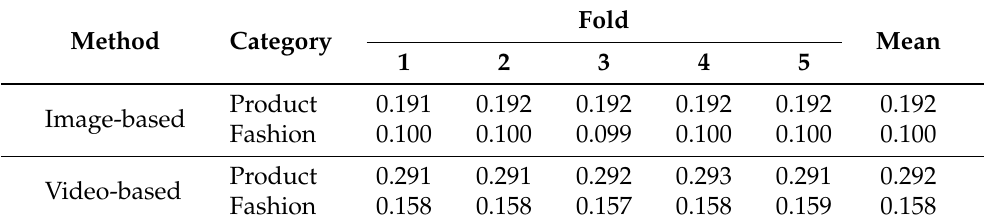
Table 3. Performance evaluation of the VERD using video-based and image-based